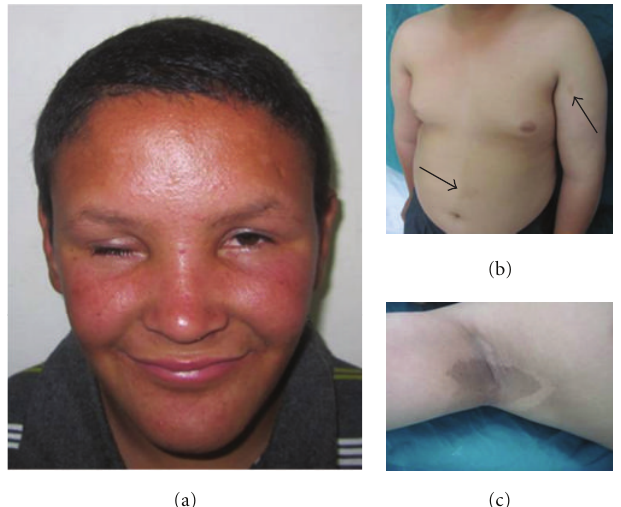
Figure 5: (a) Facial features of the proband’s maternal uncle, (b) truncal obesity and multiple caf´e au lait spots. Note large one at the right axilla